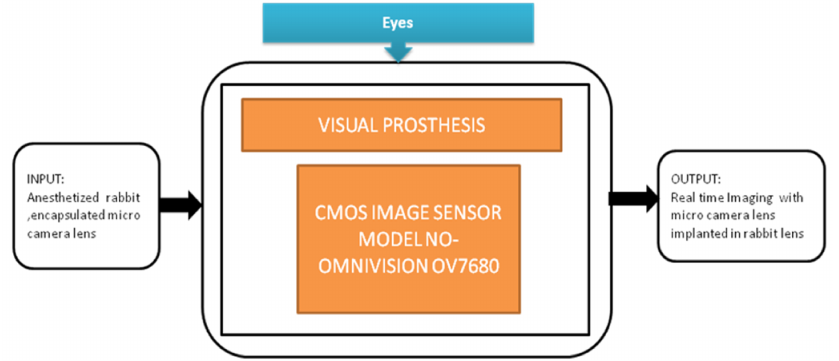
Figure 31. The implantable micro camera system in the visual